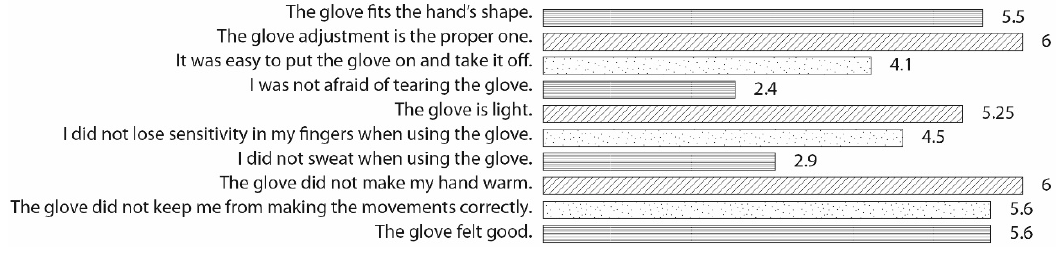
Figure 12. Users mean values for ergonomic questionnaire. Table 2. Maximum force values during the internal and external test for men and women.